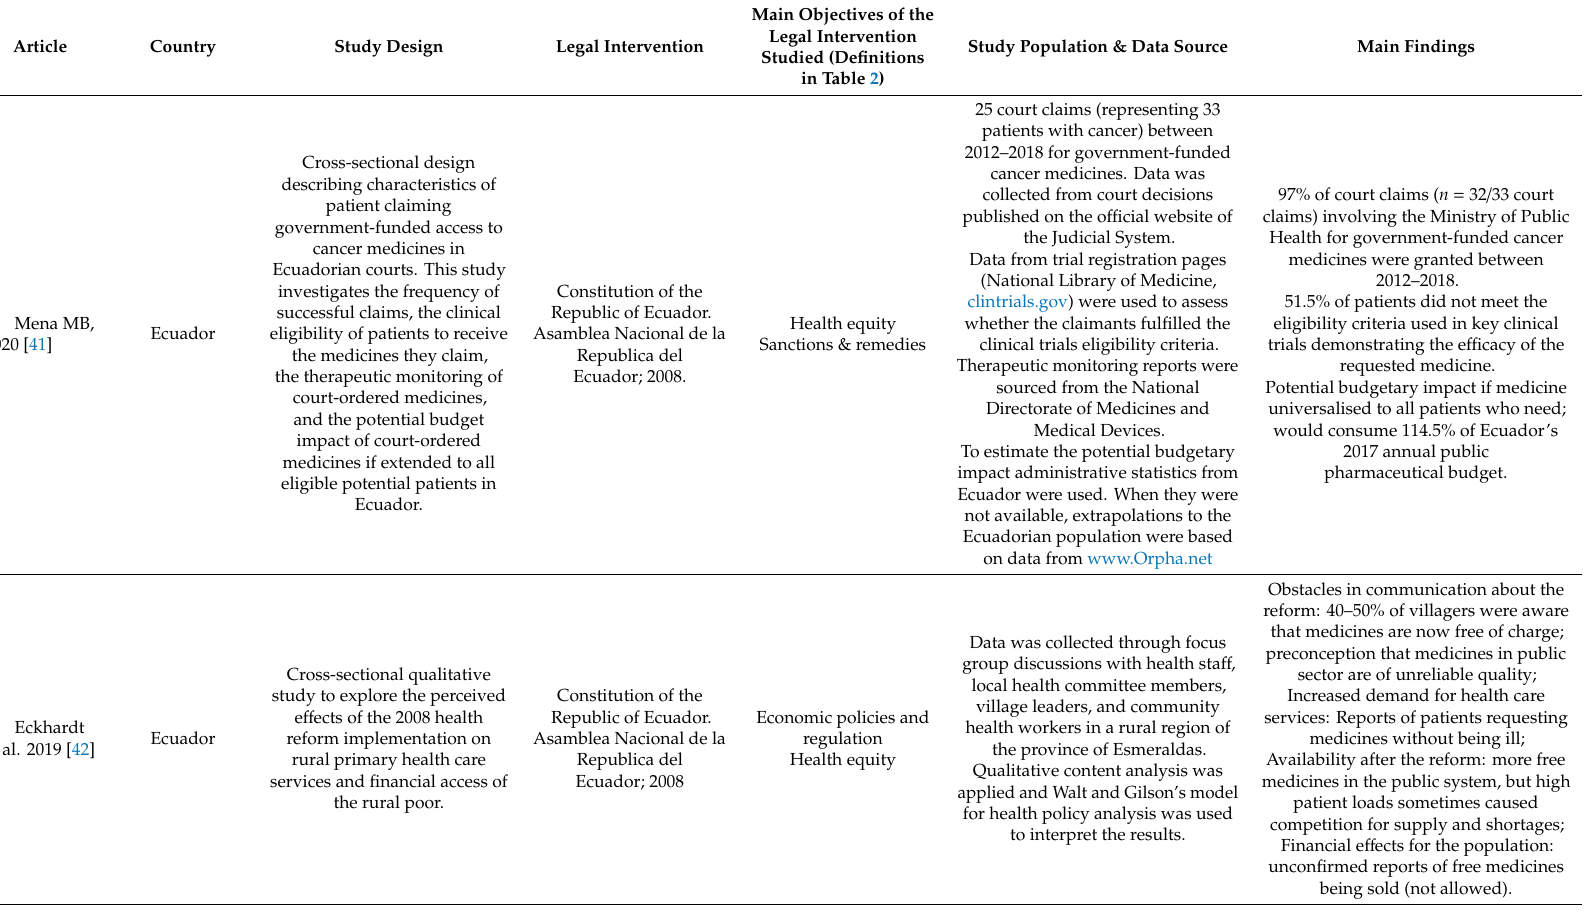
Table 4. Results of the scoping review. Evaluations of legal interventions for medicines financing and a ff ordability in five middle income